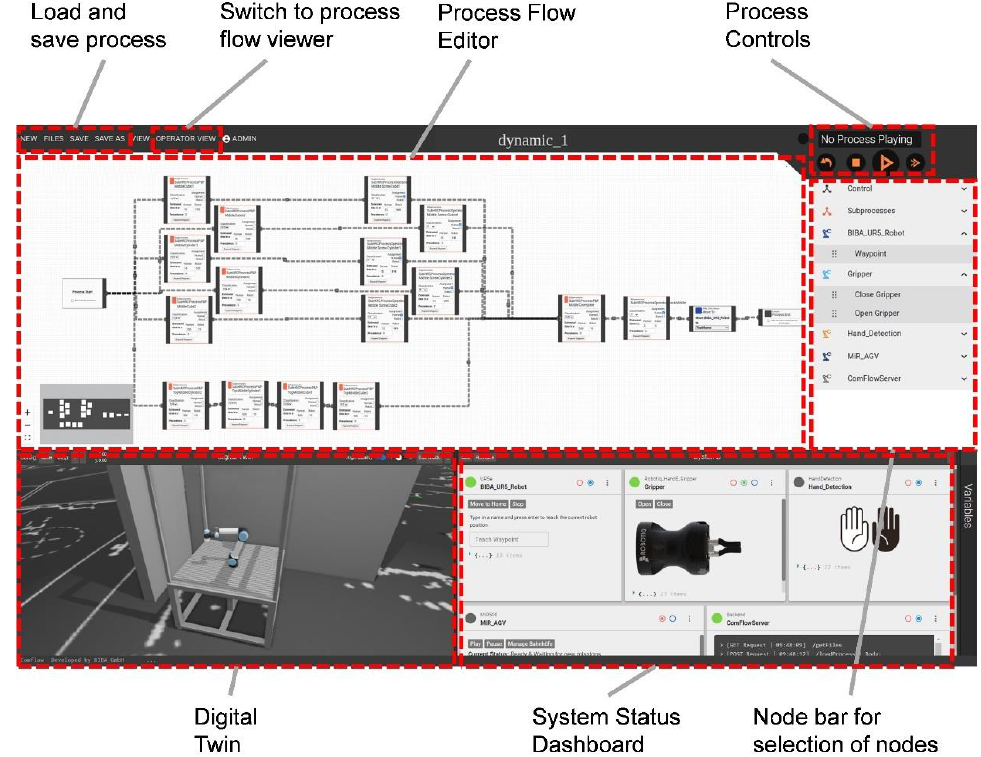
Figure 10. Web-based user interface for process creation and process execution: process flow editor for creation of the assembly process.